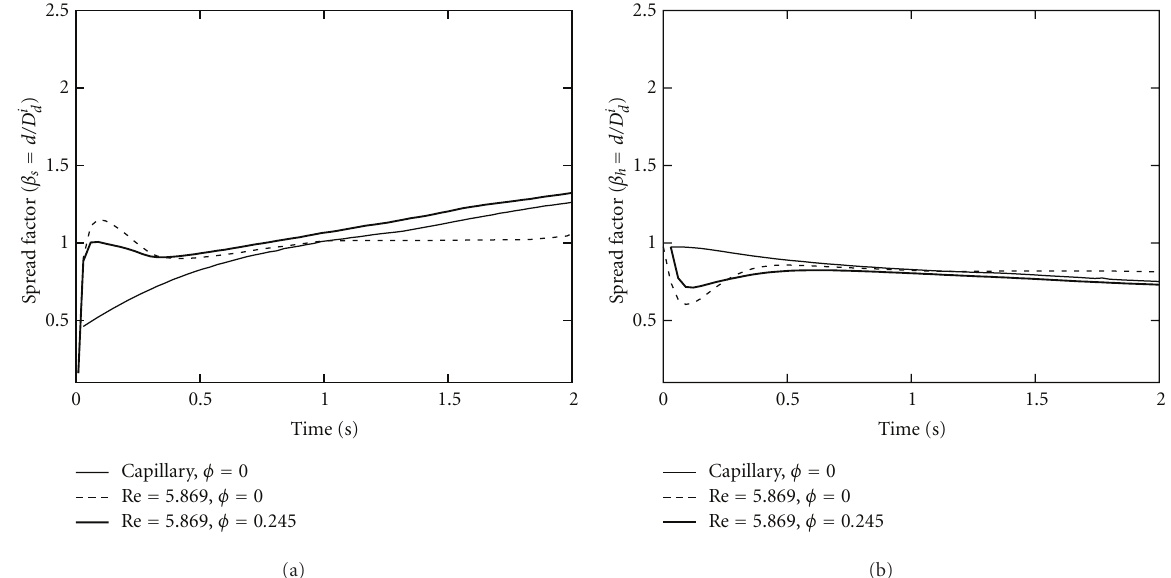
Figure 6: The droplet interfaces at the instances of (a) the maximum spreading and (b) the maximum recoils for a homogeneous fluid drop and the particulate fluid drops.